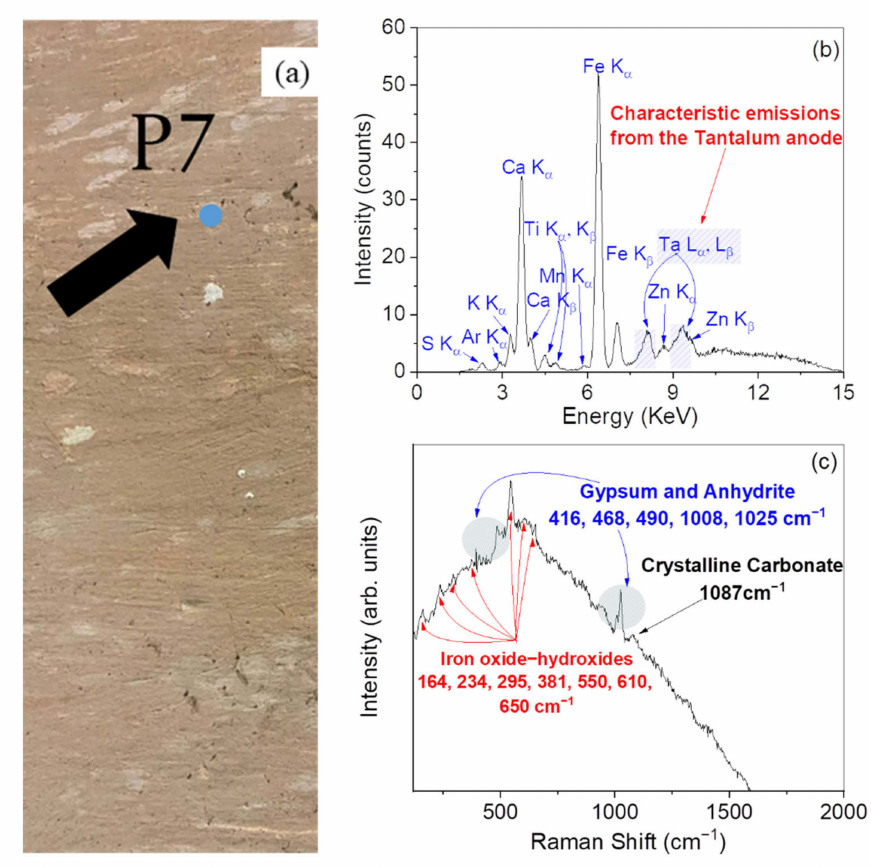
Figure 7. Photo of the point P7 (pink) ( a ). XRF spectrum recorded on the point P7 ( b ). Raman spectrum recorded on the point P7 ( c